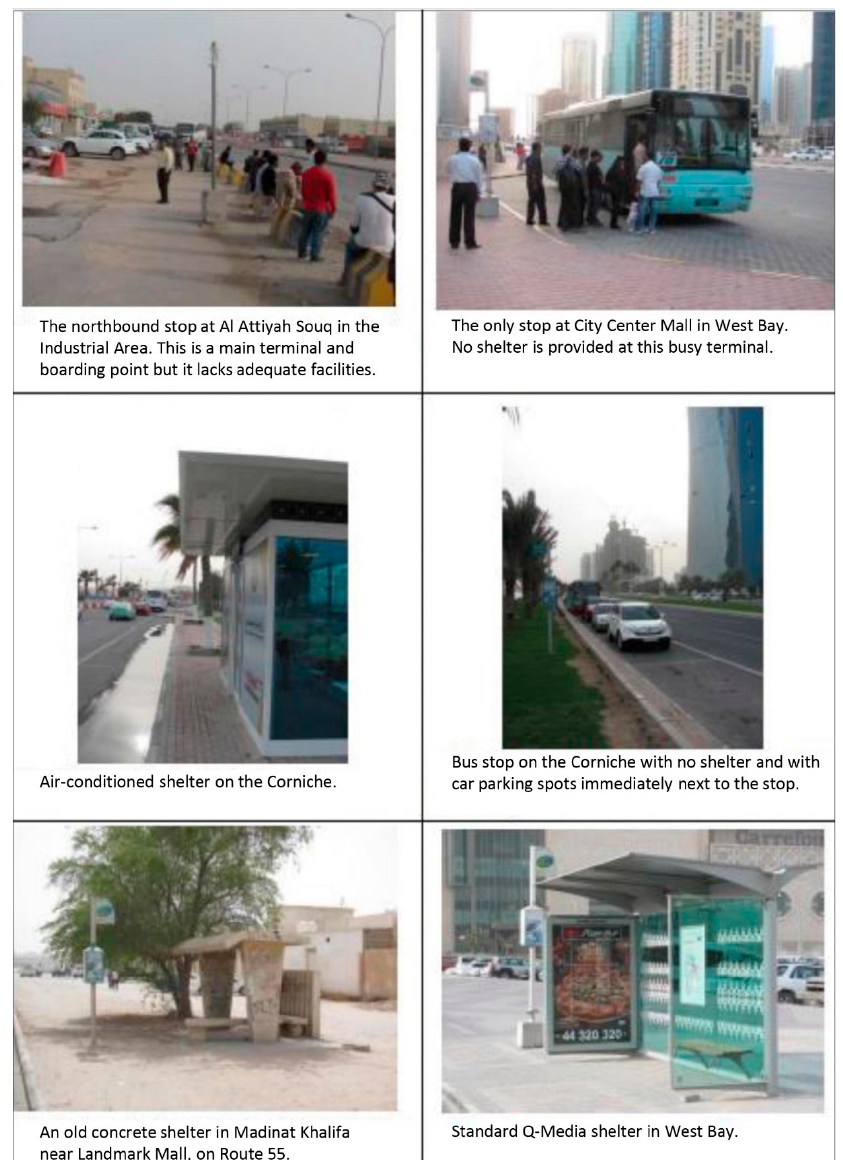
Figure 23. An illustration of how bus stops have begun changing in recent years (Sources: Central Planning Office of Ministry & Municipality of Urban Planning, Qatar. Adapted from [41]).